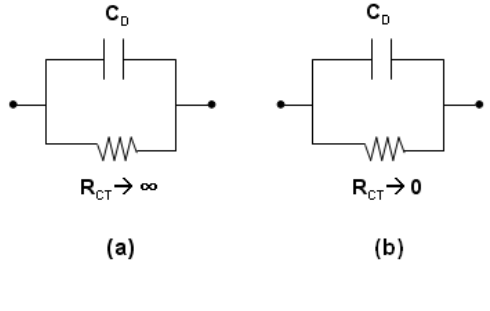
Figure 5. Equivalent circuit of (a) ideally polarizable interface and (b) ideally nonpolarizable